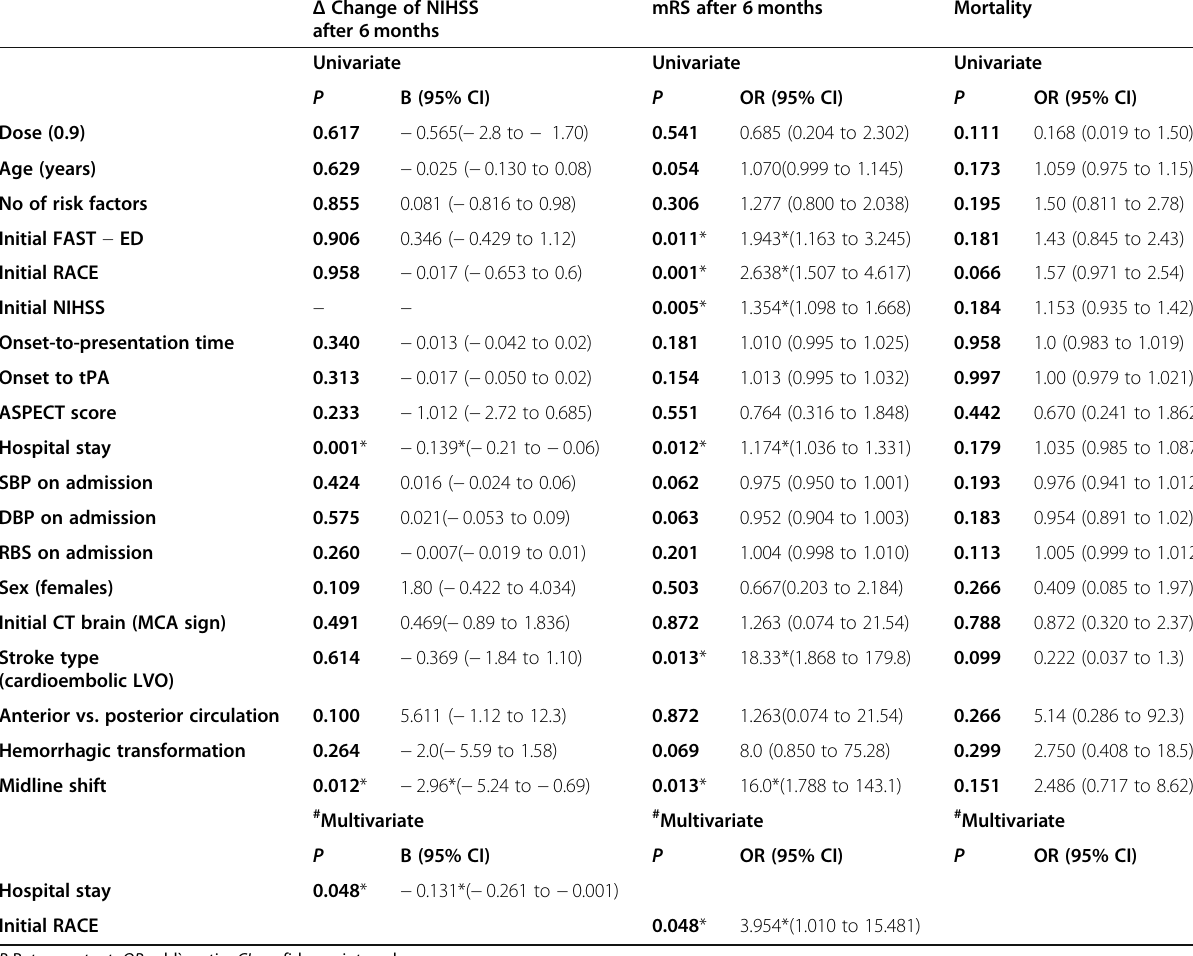
Table 6 Factors affecting the Δ change of NIHSS and mRS after 6 months and mortality (using regression analysis) Δ Change of NIHSS mRS after 6 after 6 months